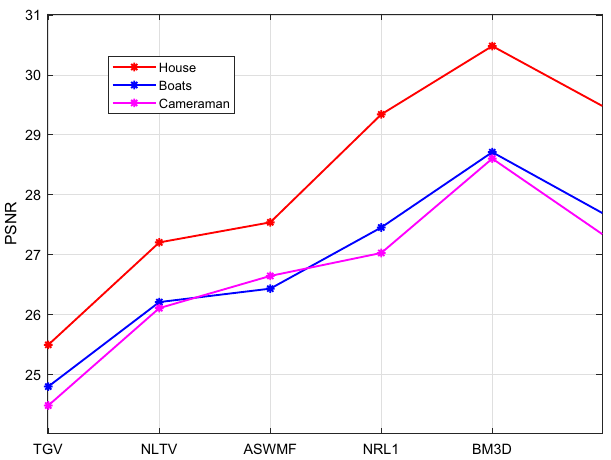
Figure 13. The plots of the relative-change of the restorations versus iterations.